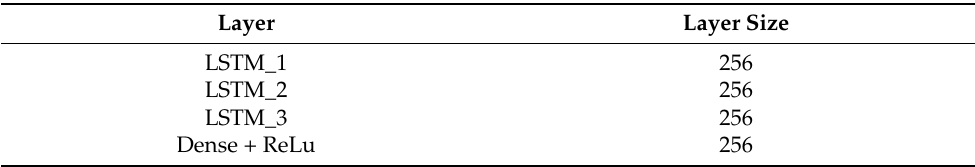
Table 3. Dvector network architecture summary